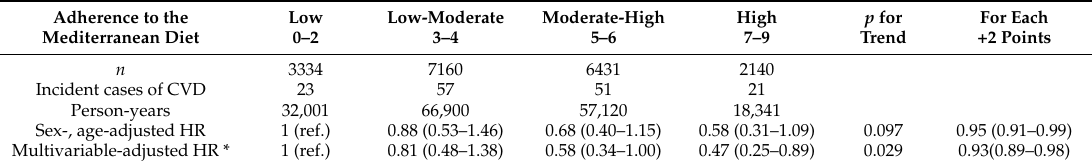
Table 3. Relative risk (Hazard Ratios and 95% confidence intervals) of incident cardiovascular disease (myocardial infarction, stroke or cardiovascular death) according to baseline adherence to the MedDiet. The SUN project